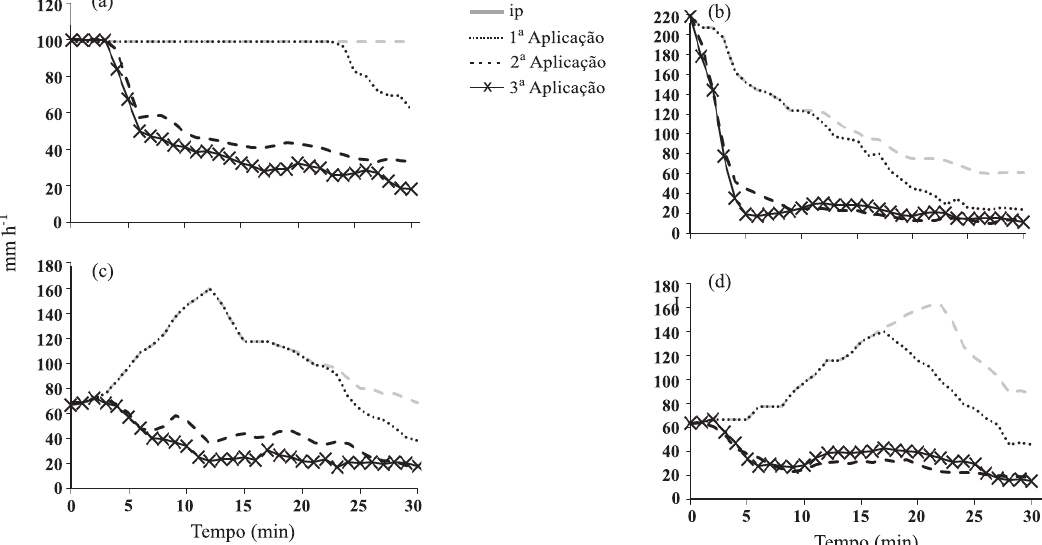
figura 4. taxa de infiltração (ti) para os três ensaios experimentais realizados consecutivamente em solo sem cobertura, espaçados de 24 h entre si, com perfil de precipitação pluvial constante (a), exponen- cial decrescente (b), duplo exponencial adiantado (c) e duplo exponencial atrasado